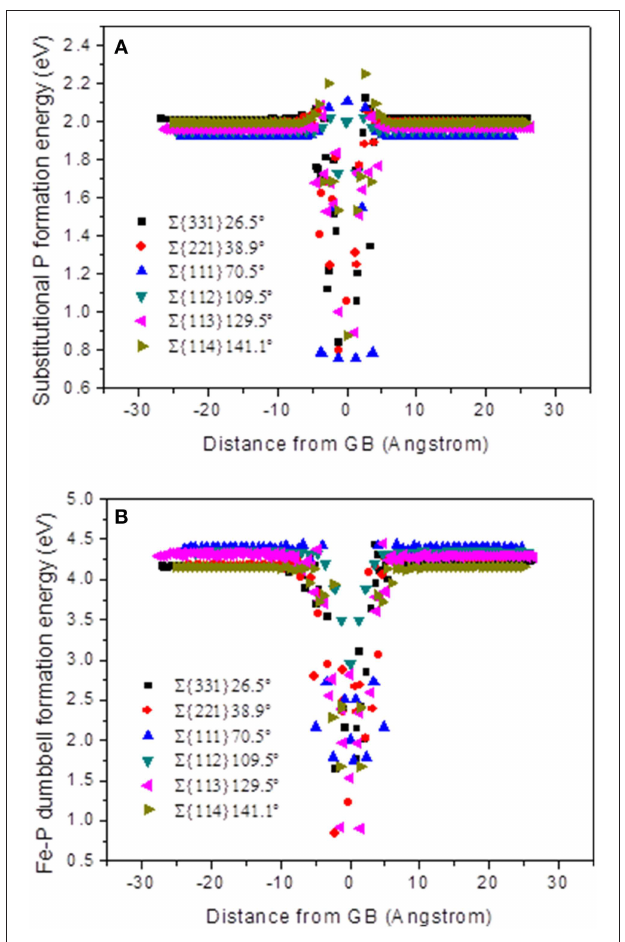
FIGURE 4 | Formation energy as a function of distance from the center of the GB for all STGBs. (A) Substitutional P formation energy and (B) Fe-P mixed dumbbell formation energy.